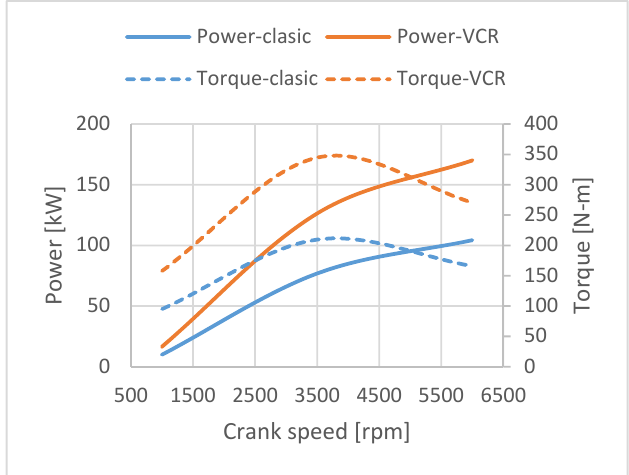
Figure 12. Engine performance: classic versus VCR.